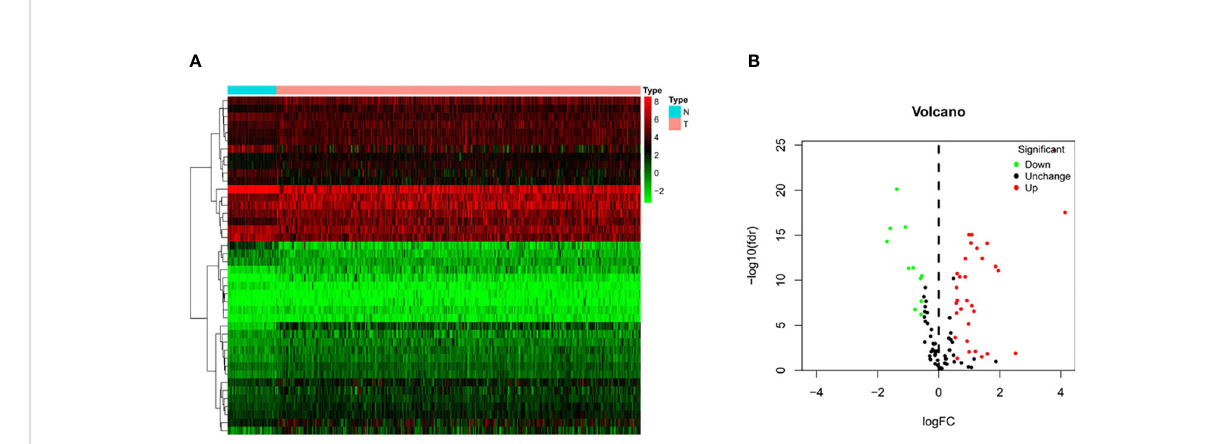
FIGURE 2 Identi fi cation of differential expressed genes (DEGs) in HCC and normal tissues. (A) Heatmap of 42 DEGs in TCGA. Red upregulation; Green downregulation. The abscissa represents the type, N normal; T Tumor; ordinate represents the gene. (B) Volcano plots of the distributions of 42 DEGs. The abscissa represents logFC and the ordinate represents -log10